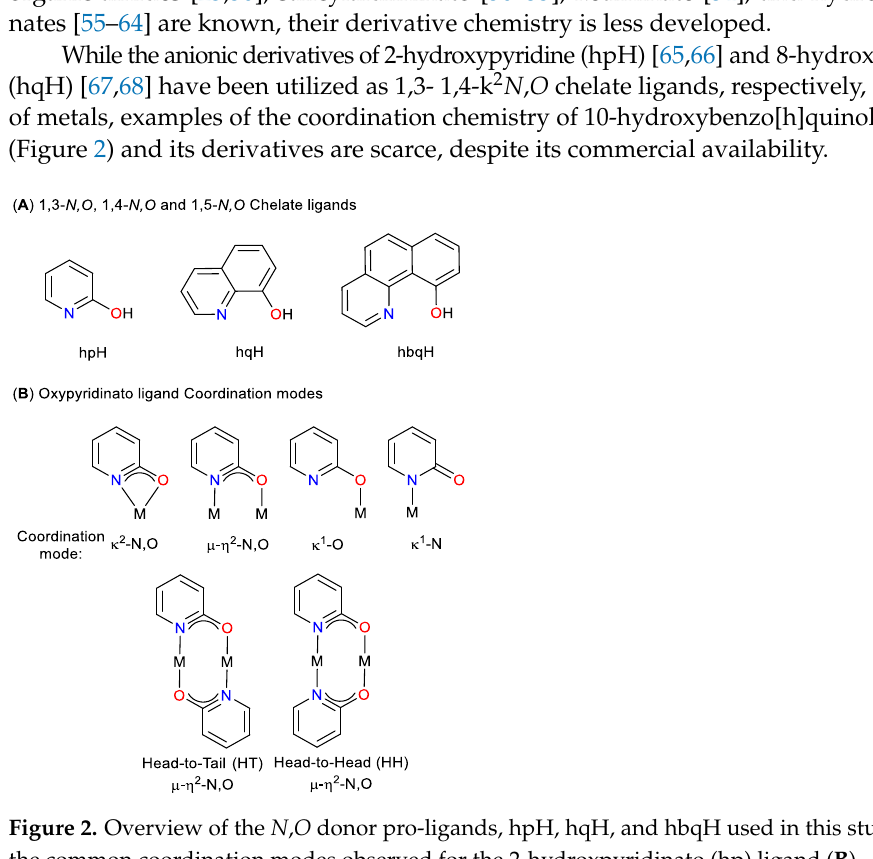
Figure 1. Stabilization of stannylene [Sn(R-L) 2-x (X) x )] complexes.